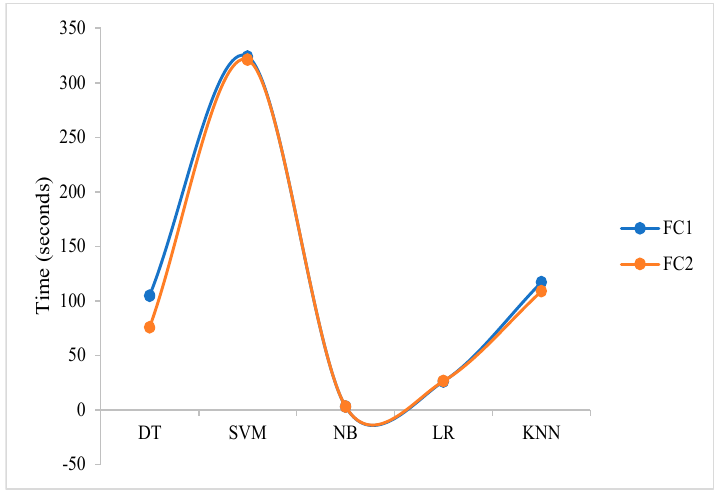
Figure 7. Training complexity of the classifiers.